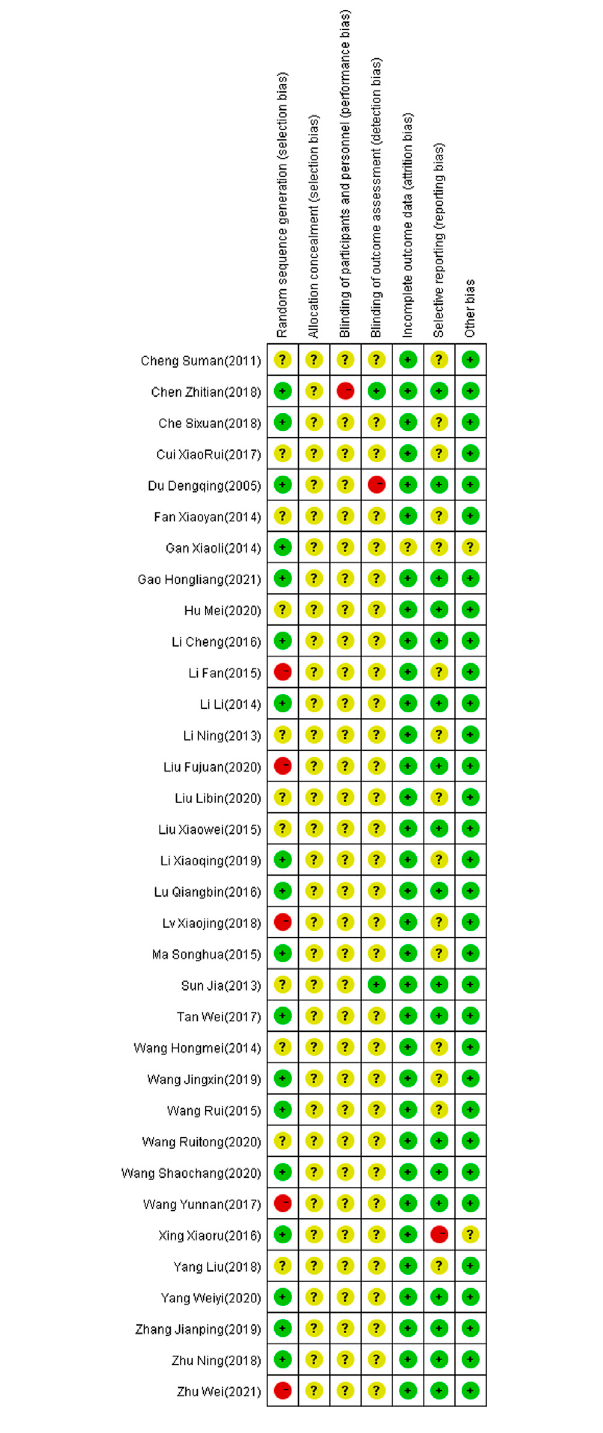
FIGURE 3 | Summary of risk of bias of included studies. Red, high risk; green, low risk; yellow, unclear